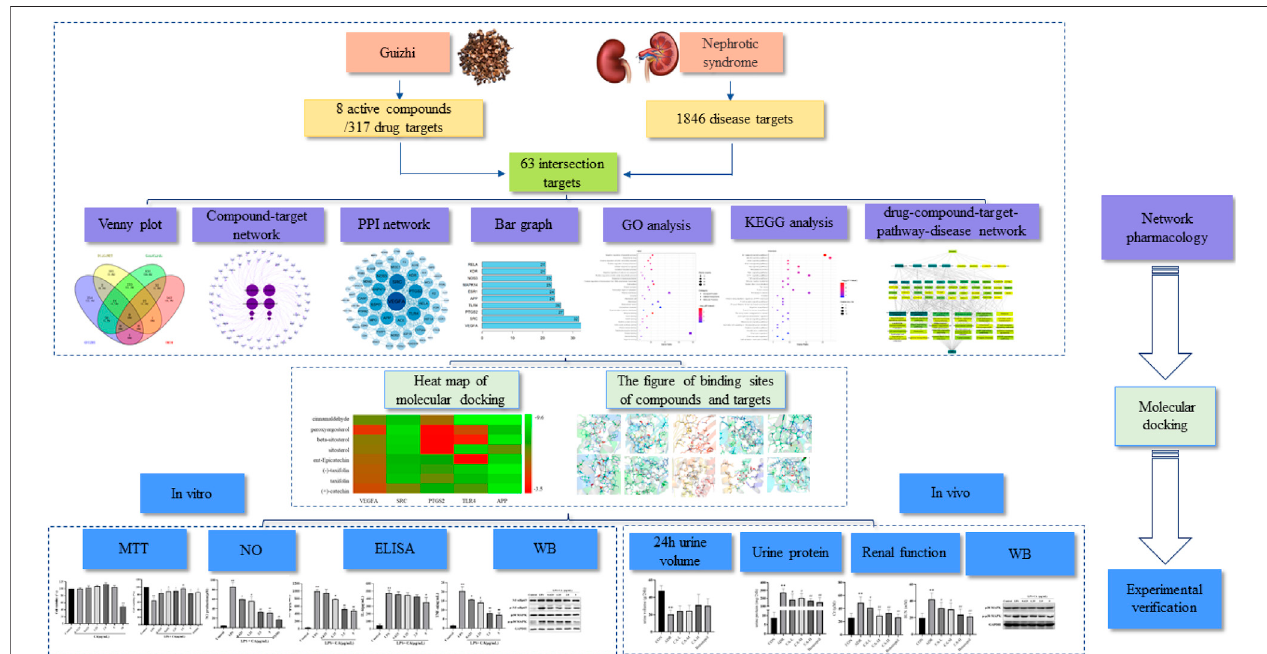
FIGURE 1 | A fl ow diagram based on a cohesive integration strategy of network pharmacology and molecular docking.